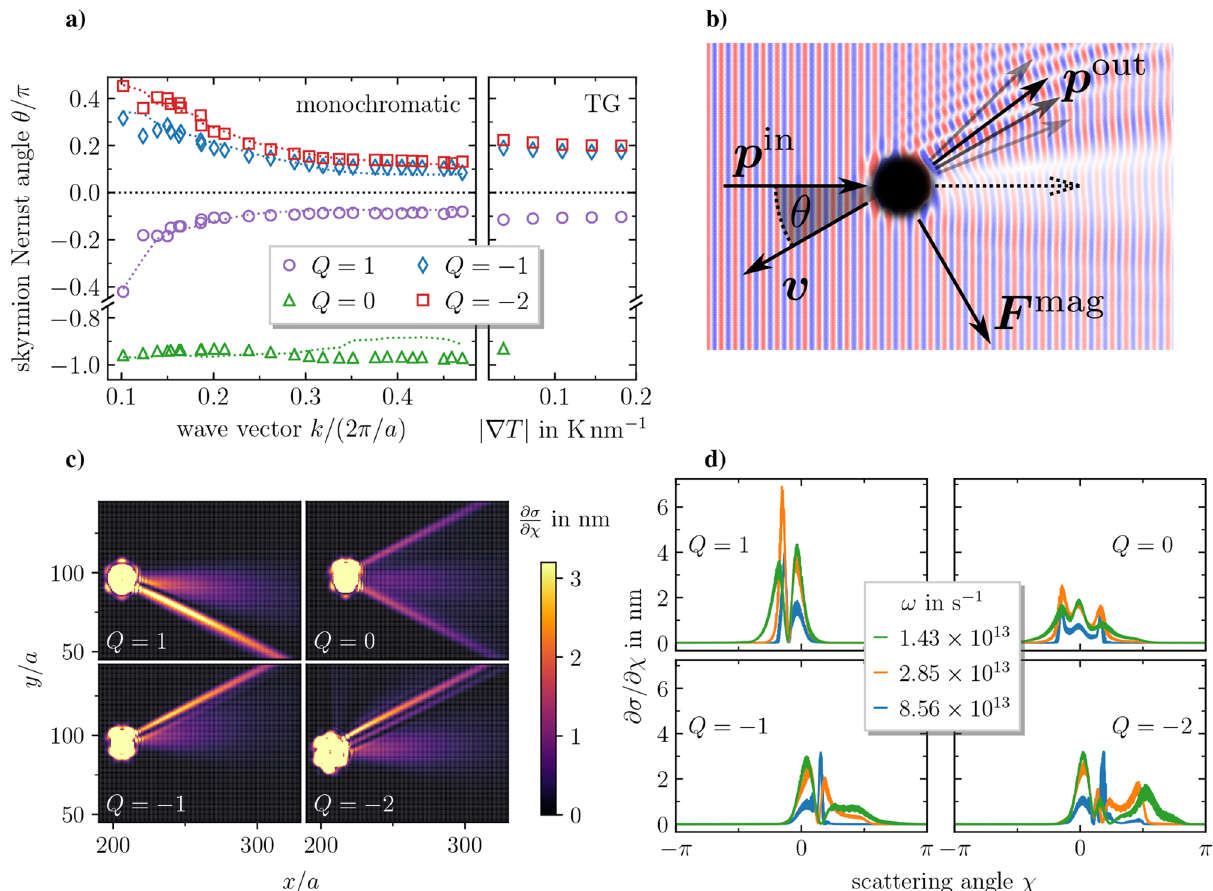
Figure 2. Skyrmionic spin structures driven by monochromatic magnon currents. ( a ) Skyrmion Nernst angle θ versus absolute value of the wave vector k of the monochromatic magnon current and strength of the temperature gradient |∇ T | for skyrmionic spin structures with different topological charges at α = 0.01 . Open symbols correspond to the simulated values and dotted lines are the predictions from Eq. (3) based on the differential cross sections. Note, that due to the lack of topological protection the chimera skyrmion gets destroyed more easily by a finite temperature as compared to the other skyrmions and it was found to be stable only at the lowest value for the temperature gradient that we simulated. ( b ) Illustration of magnons scattering at an antiskyrmion. The magnons are emitted from the left with momentum p in and, after being scattered, leave the system with p out , giving rise to the force F mag via Eq. (1). For finite Q and small α , Thiele’s Eq. (2) predicts that the velocity v is perpendicular to the force. For the antiskyrmion, the direction of the velocity can hence be obtained by a clockwise rotation of F mag . ( c ) Differential cross sections as a function of spatial coordinates x , y obtained from simulation data for ω = 8.56 × 10 13 s − 1 and α = 0.01 . The color coding has a cutoff value of ∂σ/∂χ = 3.2nm for the sake of visibility, because our method of calculating the differential cross section (see Supplemental Material) yields very large values in the vicinity of the skyrmion core, where it is not applicable anyway. ( d ) Differential cross sections as a function of the scattering angle χ obtained from simulation data for α = 0.01 . They are obtained by selecting all values of ∂σ/∂χ within an annulus of width 10 a with an outer diameter of 40 a